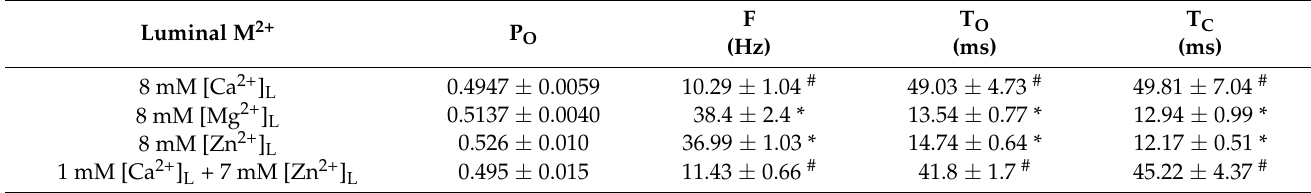
Figure 2. Luminal Zn 2+ mixed with Ca 2+ increases RYR2 currents under non-saturating conditions. Representative RYR2 currents (digitally filtered at 250–400 Hz), shown as upward deflections from the marked zero-current level, in the absence (control, left five traces) and after luminal Zn 2+ exposure (right five traces). In total, 4, 5, 6, 7 mM [Zn 2+ ] L was added to 4, 3, 2, 1 mM [Ca 2+ ] L (control), respectively, to keep the total divalent concentration constant at 8 mM. Representative RYR2 recordings for pure 8 mM [Ca 2+ ] L (control) and 8 mM [Zn 2+ ] L are also shown. RYR2 channels were activated by 1–2 mM caffeine in the presence of 90 nM free [Ca 2+ ] C . In the presence of 8 mM [Zn 2+ ] L , caffeine concentration was increased to 6–7 mM. Current recordings were conducted at 0 mV and are from different channels. Table 1. Effects of luminal M 2+ (M 2+ : Mg 2+ , Zn 2+ or Ca 2+ ) on gating parameters of the RYR2 channel at P O ~ 0.5.